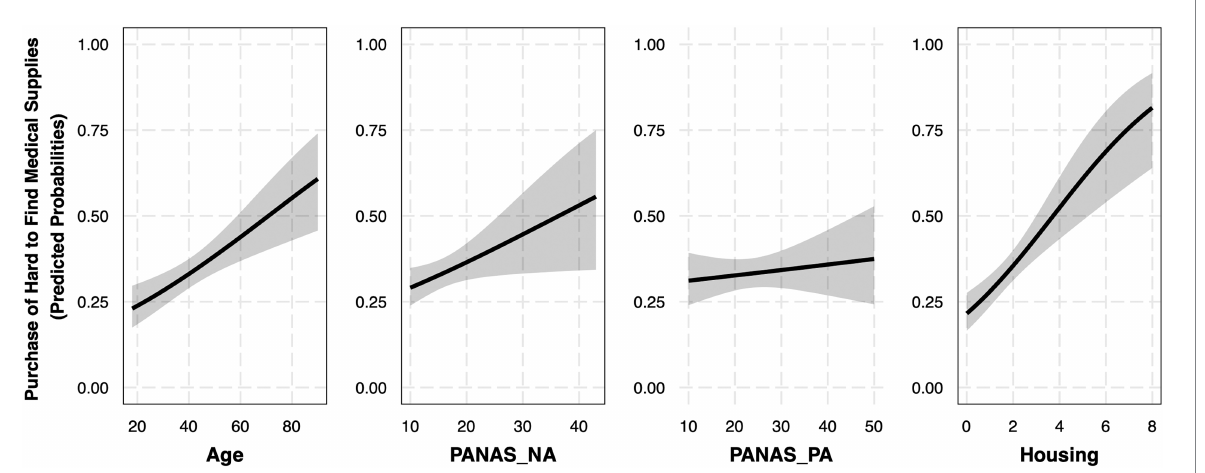
FIGURE 4 Purchase of hard-to-find medical supplies is significantly related to age and negative affect (Controlling for housing). Each plot represents the effect of a given independent variable controlling for the other independent variables in Medical Model 1.1 (Control: Housing). Independent variables that produced significant effects have black borders. All variables were mean-centered in this model with the exception of housing, but for visualization purposes all variables are plotted with uncentered values. N = 507.